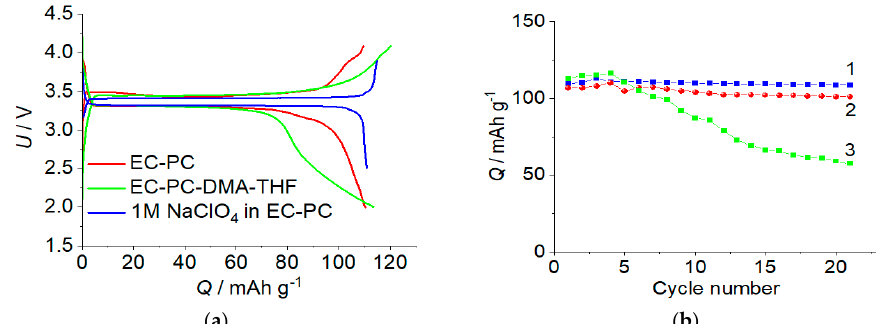
Figure 5. Charge–discharge curves ( a ) and cycling stability ( b ) for coin cells with liquid (1) and polymer electrolytes (2, 3). (1) — 1 М NaClO 4 in EC-PC, (2) — Nafion 117 membrane, intercalated by EC-PC mixture, (3)—Nafion 117 membrane, intercalated by a EC-PC-DMA-THF mixture.The capacity was normalized by a weight of cathode active material current density of 10 mA · g − 1